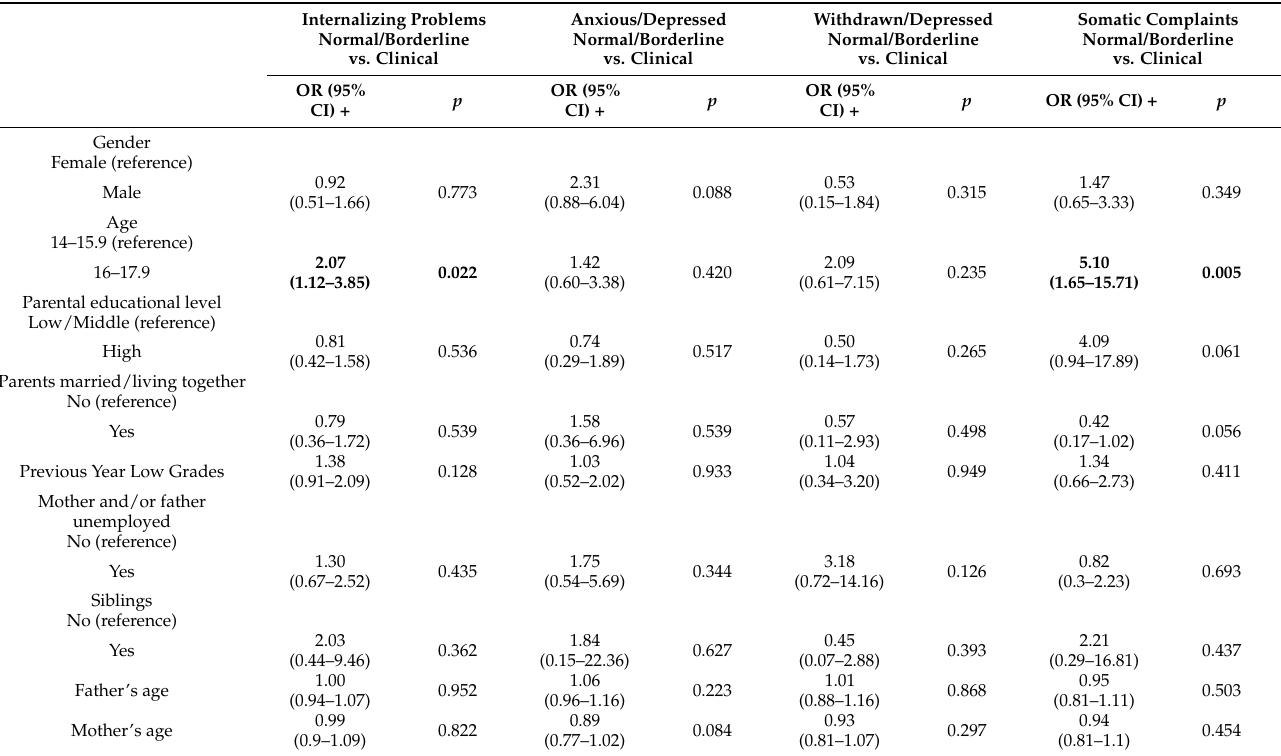
Table 8. Results from multiple logistic regression analysis with clinical internalizing problems (in all subscales and in total) as the dependent variable for The Netherlands . Bold cells denote statistically significant